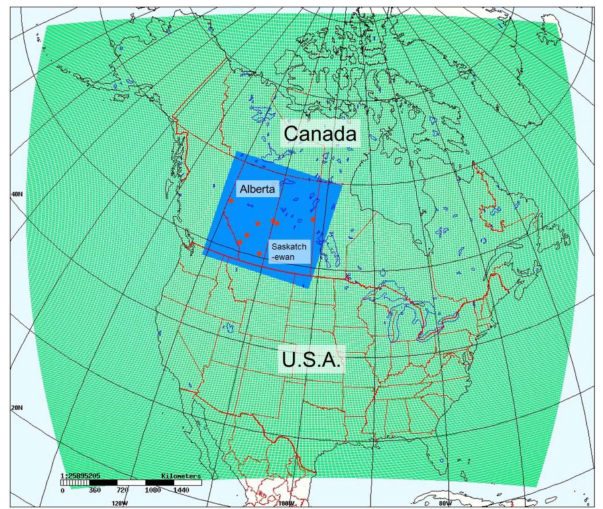
Figure 1. GEM-MACH domains. Green region: outer North Ameri- can domain (10km × 10km grid-cell resolution). Blue region: inner Alberta and Saskatchewan domain (2.5km × 2.5km grid-cell res- olution). Red diamonds: locations of Canadian Acid Precipitation Monitoring Network (CAPMoN) stations used in this